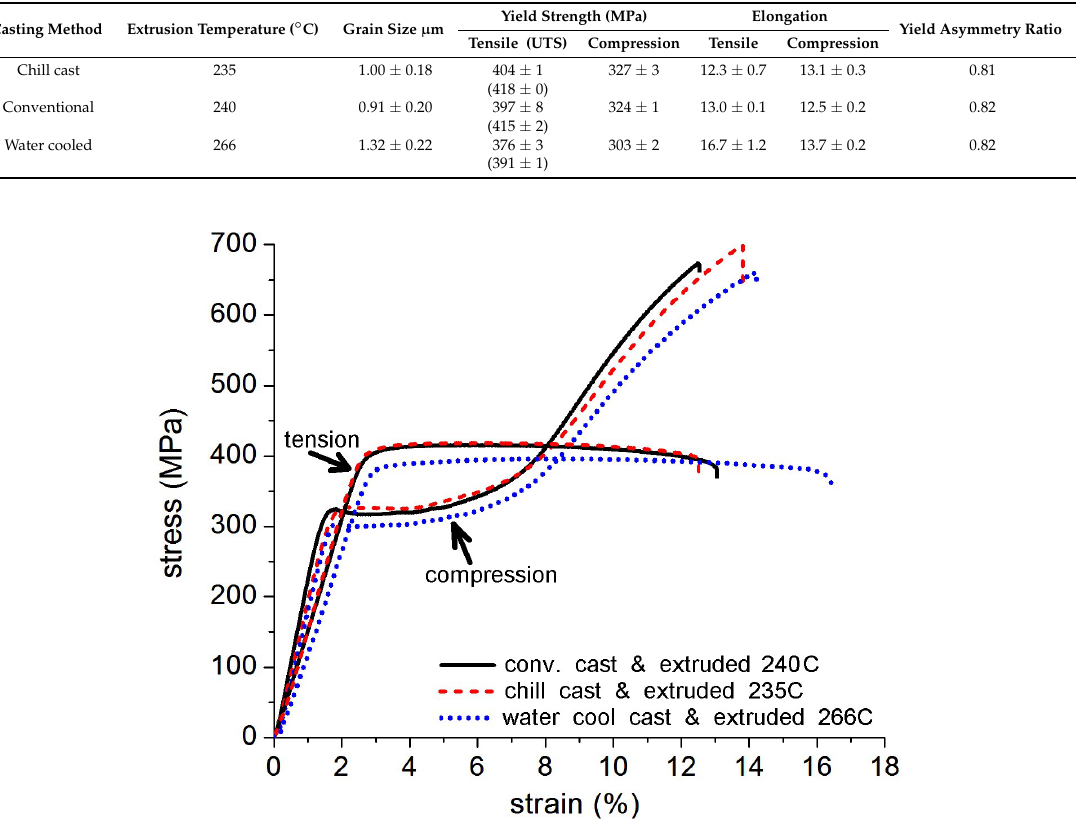
Figure 12. Engineering stress-strain plots for tensile and compression tests on extruded rods made from chill cast, conventional and water-cooled mold